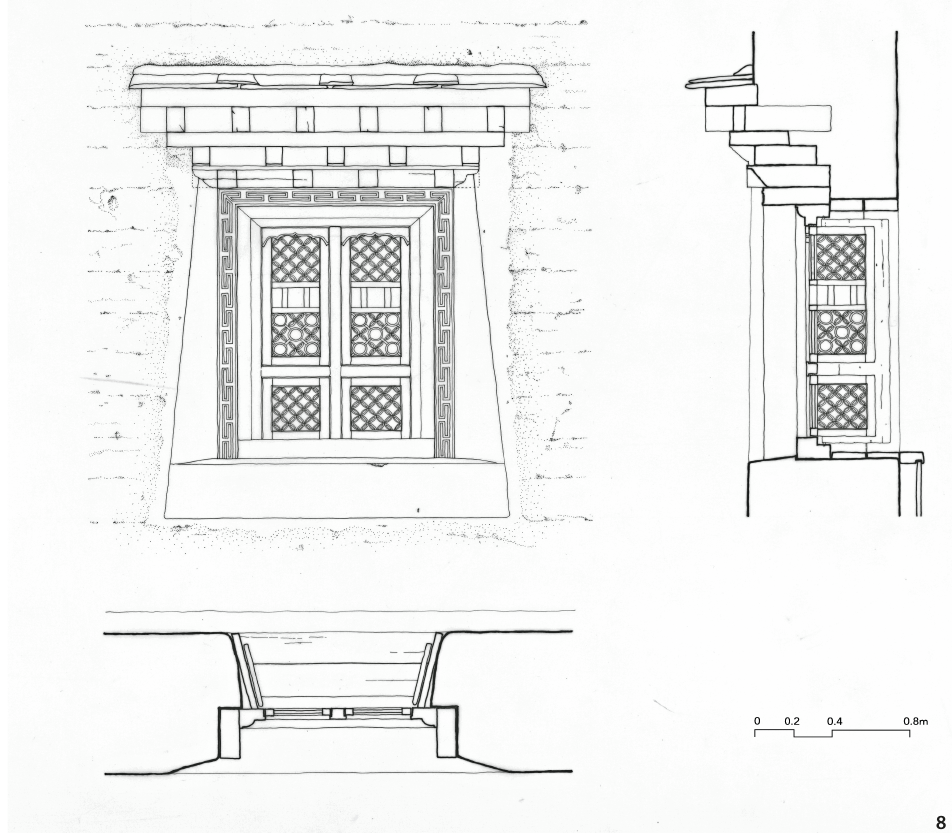
Figure 8 Details of the window of the farmhouse in Chatreng (Source: the authors).